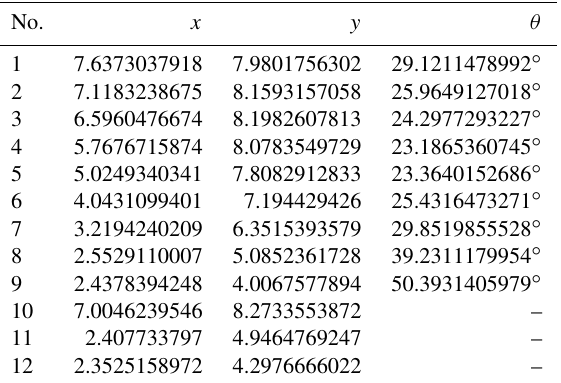
Table 2. List of points and poses traced by coupler link. Table 3. Final result of the mixed synthesis